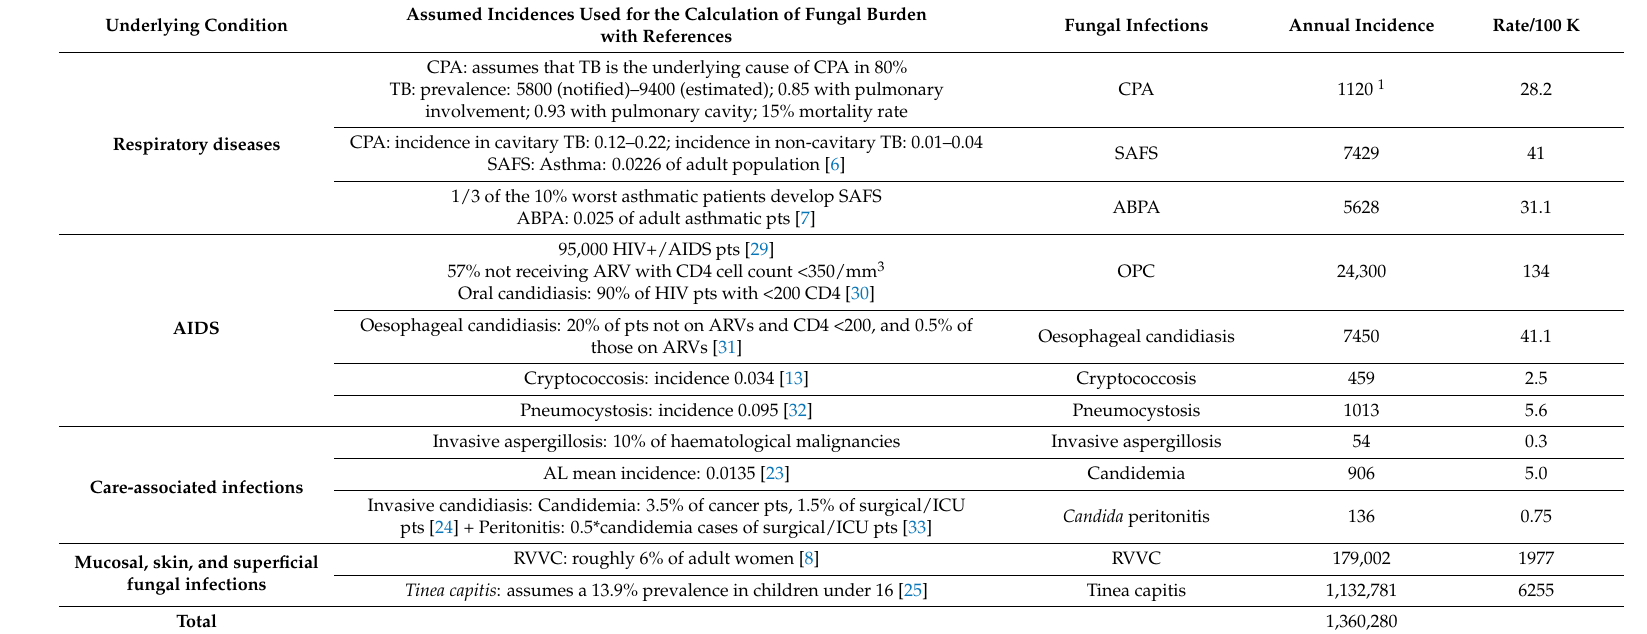
Table 1. Estimate of the burden of fungal diseases in Burkina